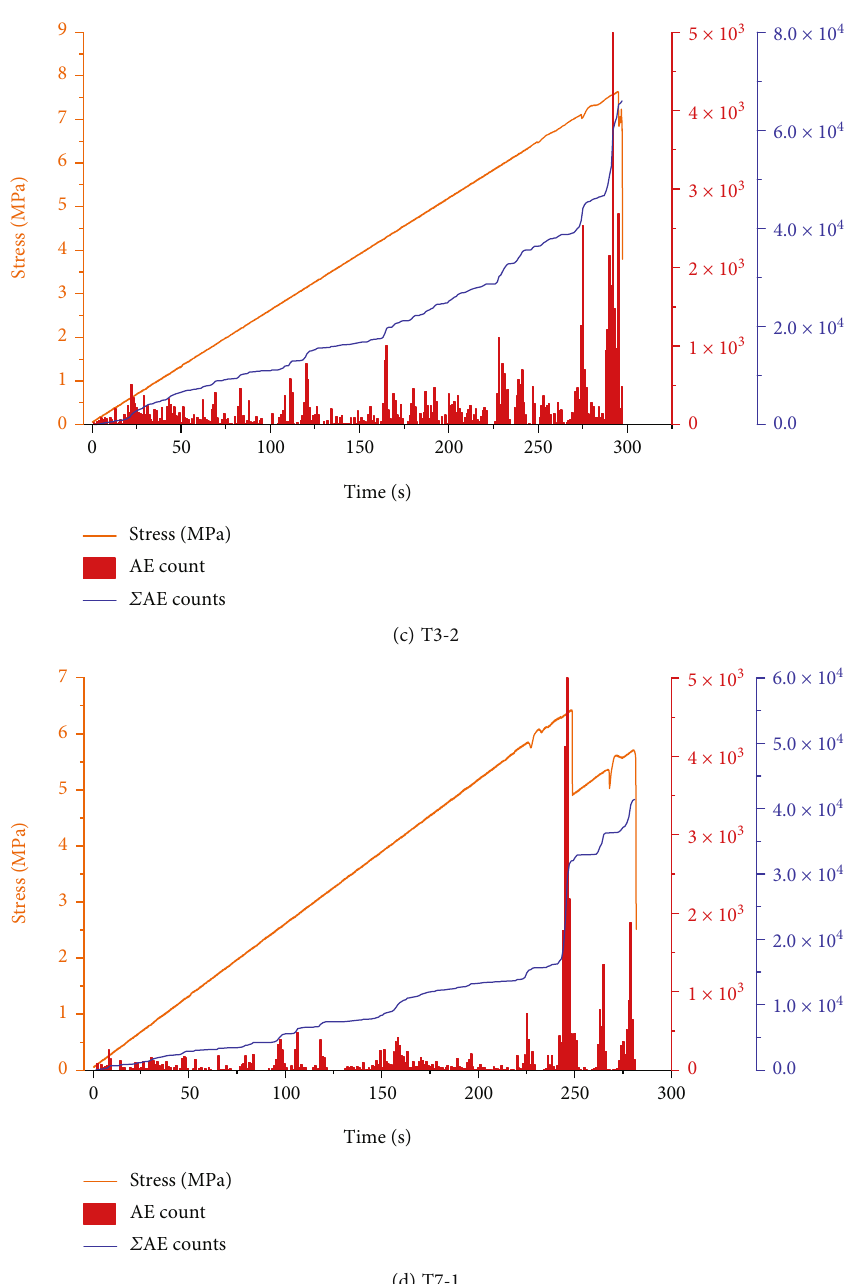
Figure 4: Relationships of stress, AE counts, and cumulative AE counts with time in the Brazilian indirect tensile test for di ff erent moisture